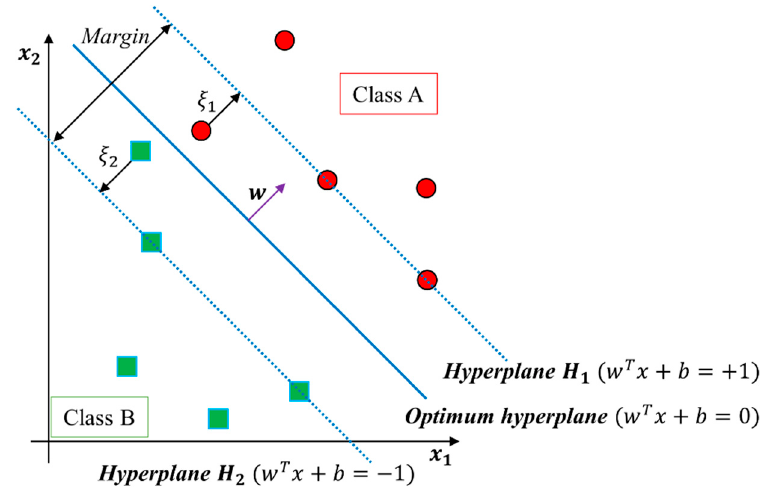
Figure 4. Main concept of SVM in a linearly separable case [25].